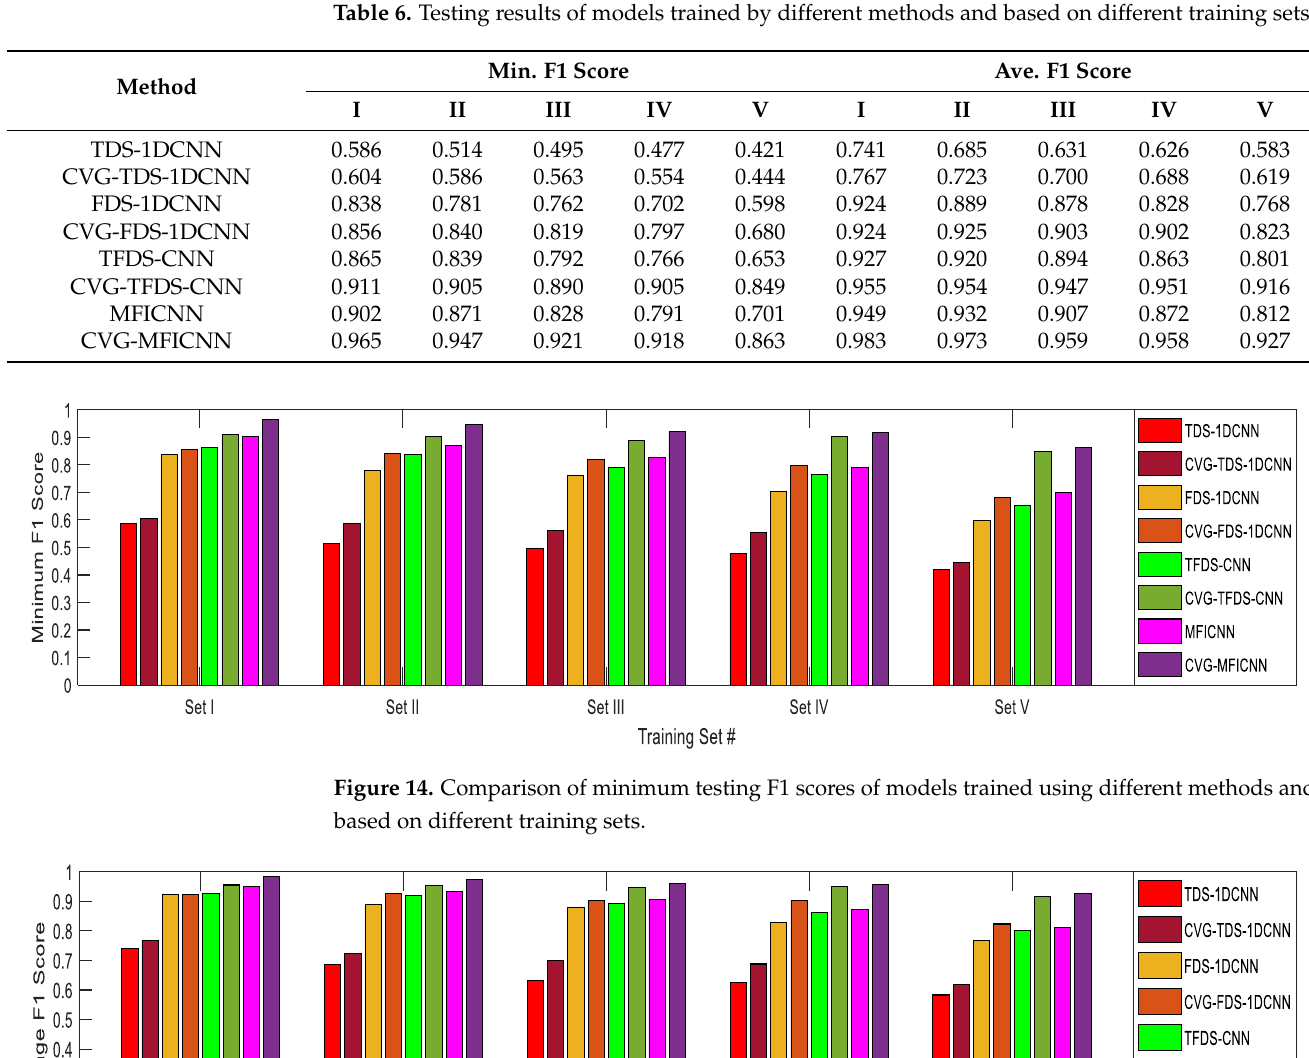
Table 6. Testing results of models trained by different methods and based on different training sets.